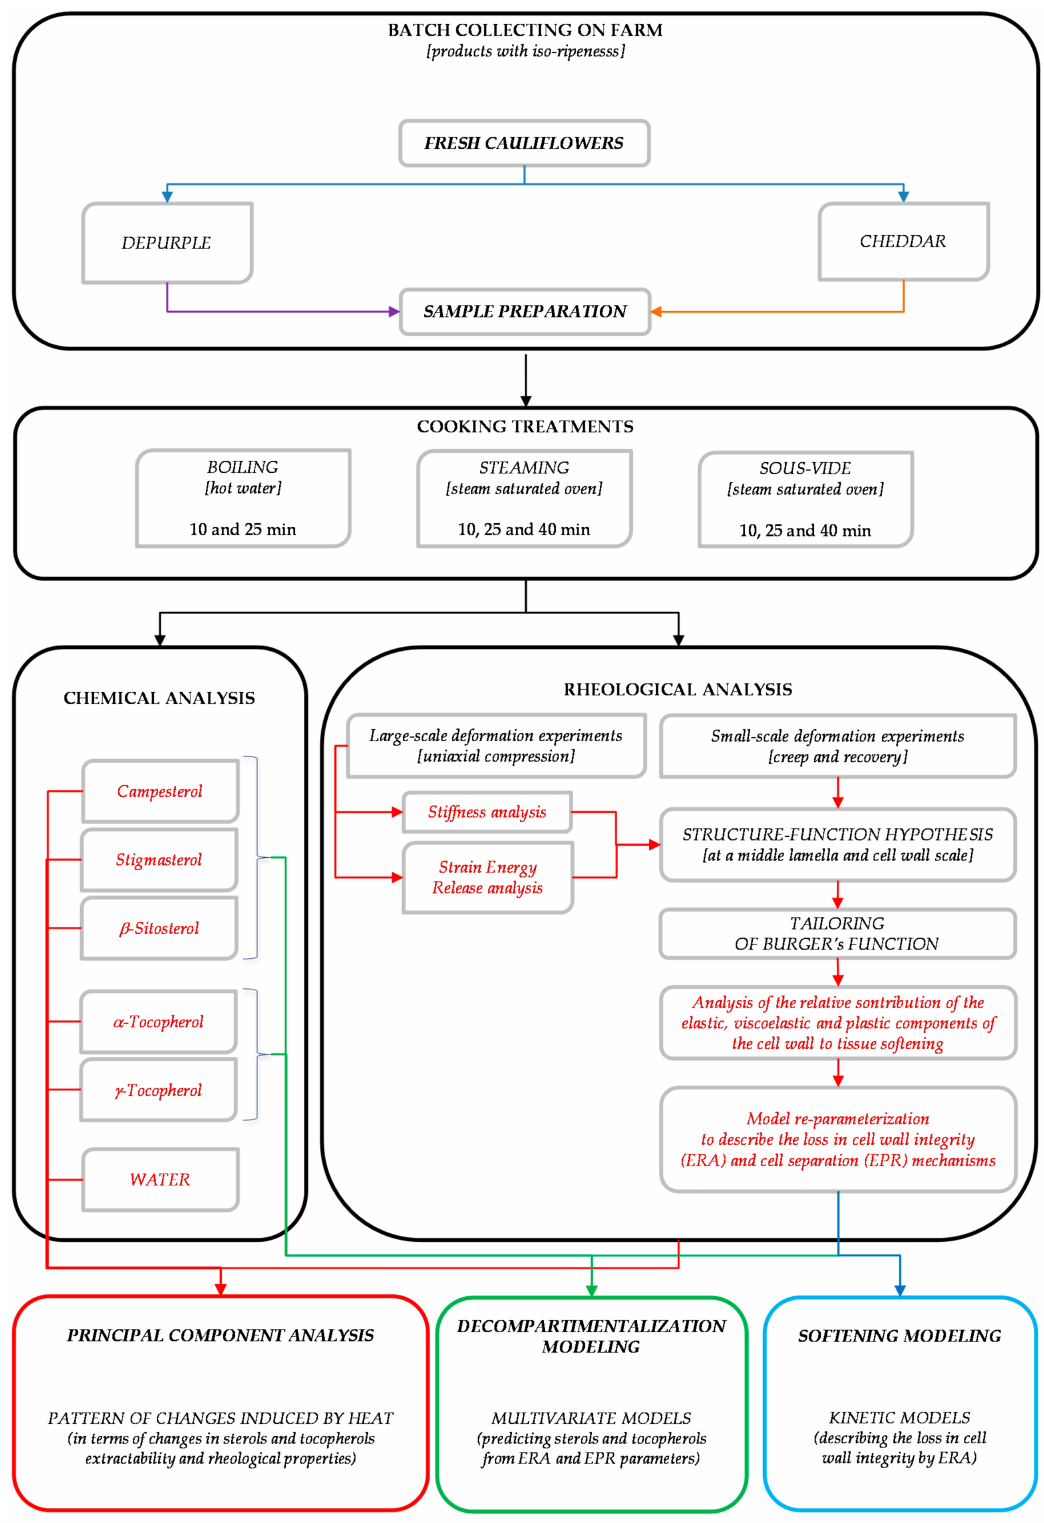
Scheme 1. Flow diagram that explains the experimental